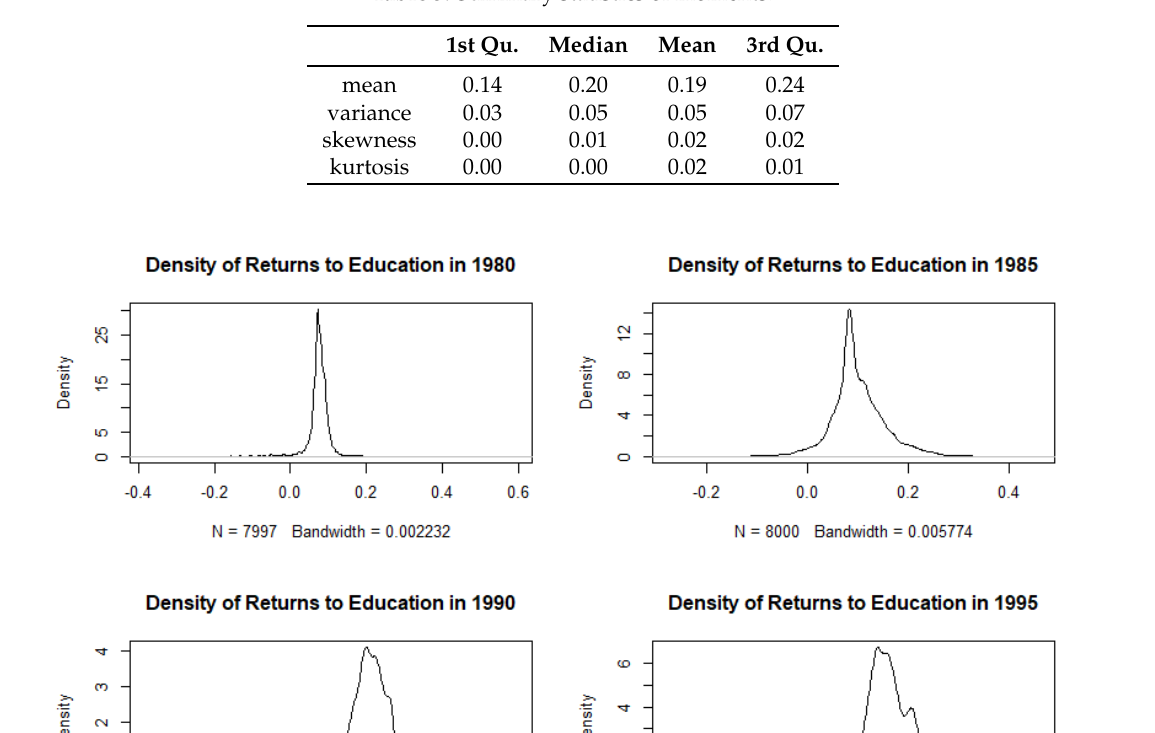
Table 3. Summary statistics of moments.